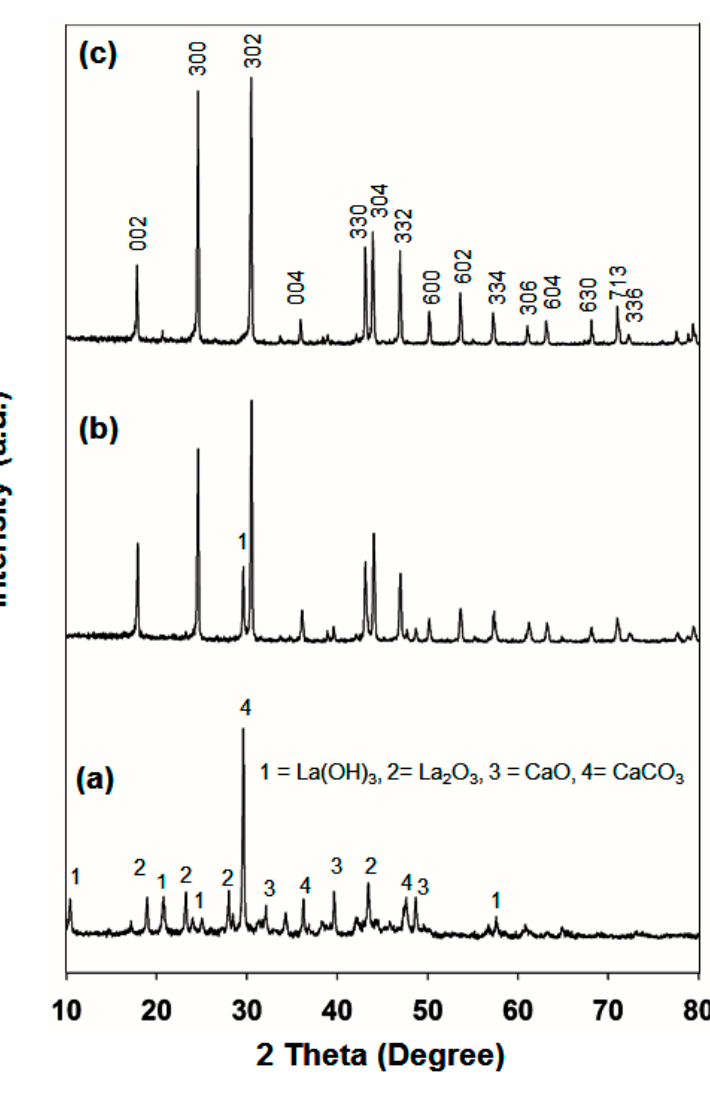
Figure 1. X-ray diffraction (XRD) patterns of ( a ) LC-1, ( b ) LC-2, and ( c ) LC-3 samples prepared by the hydrothermal process at 200 °C, for 24 h at pH 8.5.